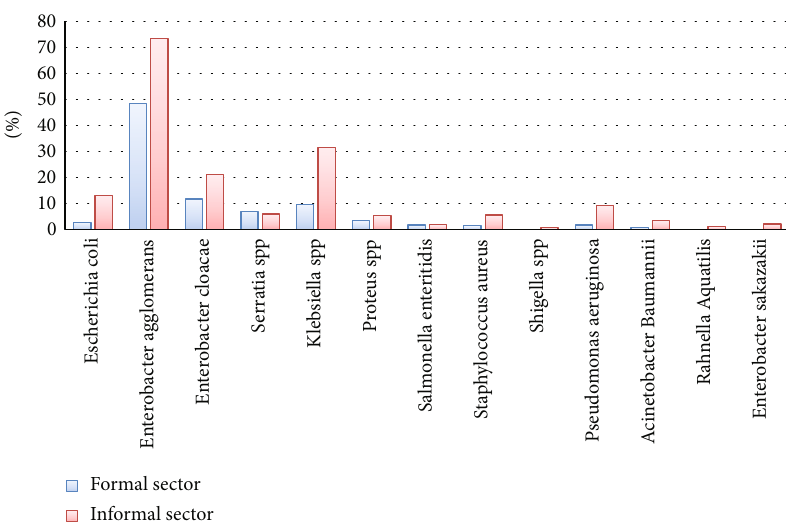
Figure 2: Bacterial organisms identi fi ed from eggs of the formal and informal